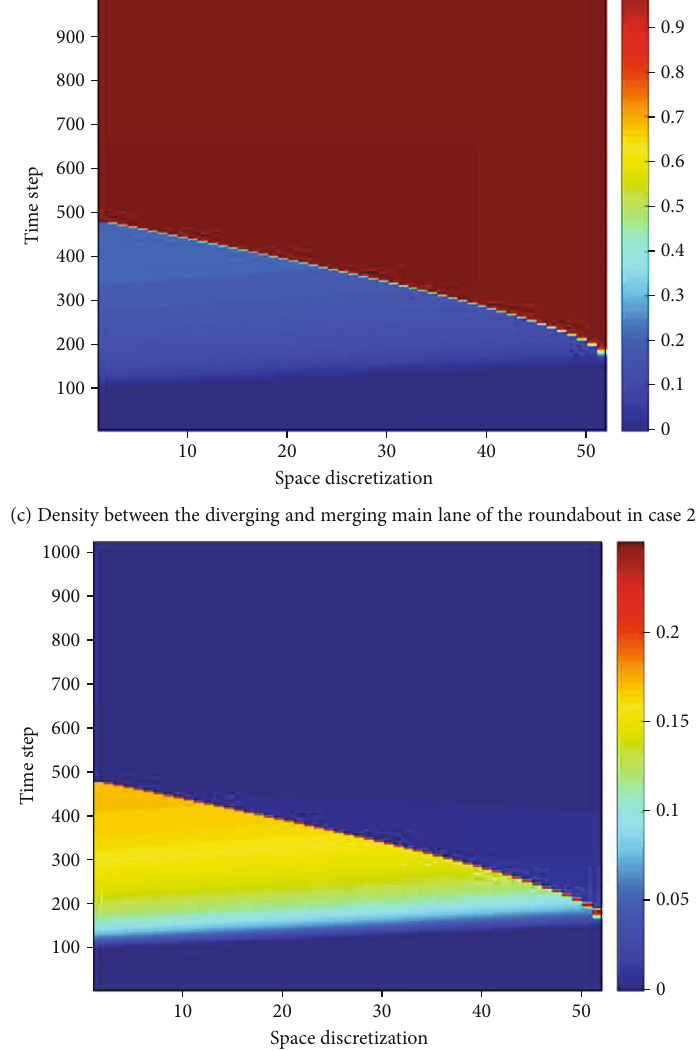
Figure 7: Density and fl ux pro fi les on the entrance and main lane of a roundabout in case 2. Due to tra ffi c congestion, shock waves are produced on roads ( I